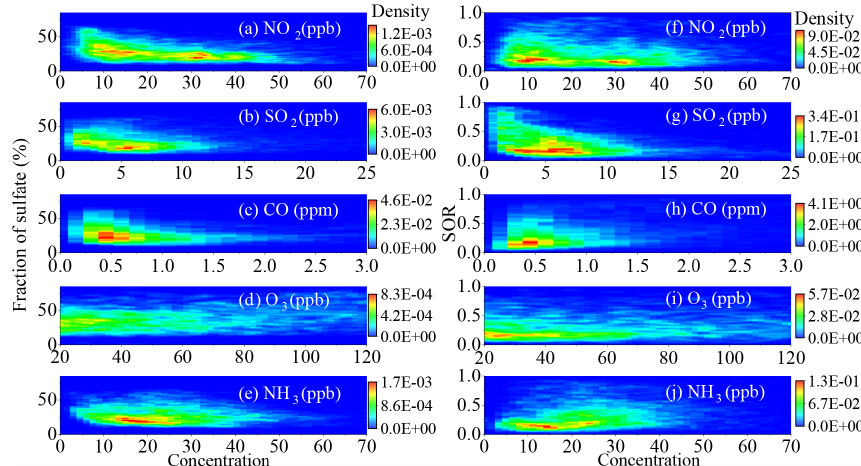
Figure 6. Dependence of the sulfate fraction in soluble PM and the SOR on gaseous pollutant concentration in Shijiazhuang.